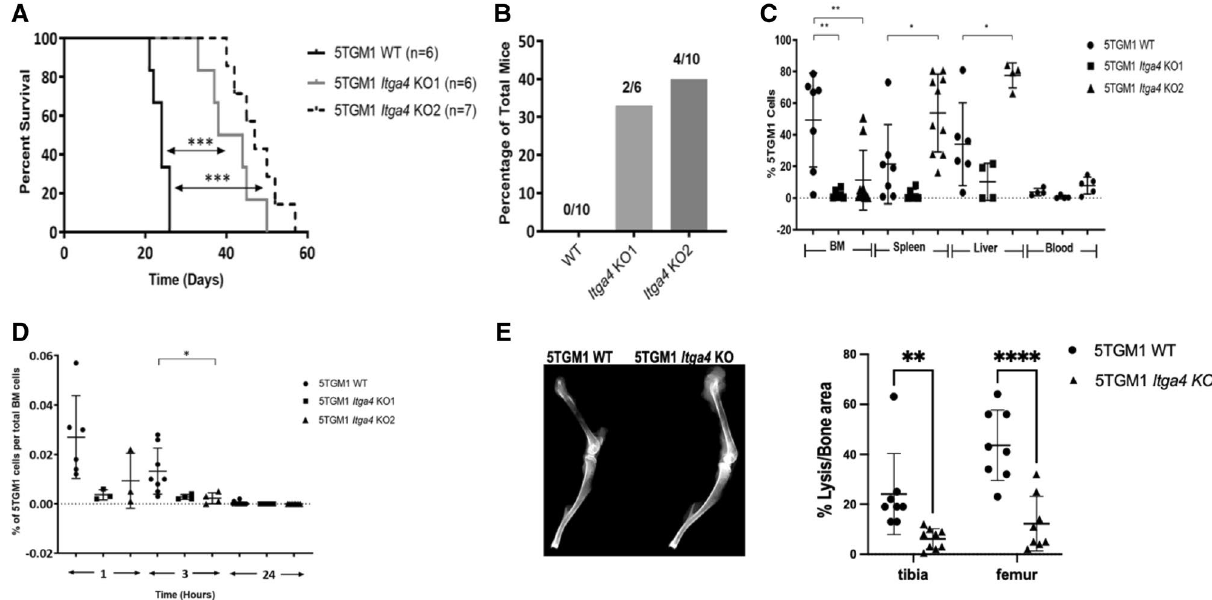
Figure 3. The in vivo characteristics of the Itga4 KO 5TGM1-GFP cells were compared with the WT 5TGM1- GFP cells in the intravenous (i.v.) KaLwRij mouse model. ( A ) The Itga4 KO 5TGM1-GFP cells engrafted in immunocompetent C57BL/KaLwRij mouse model demonstrated significant survival advantage. ( B ) Quantitation of number of mice that developed extramedullary tumors detected in mice engrafted with WT or Itga4 KO 5TGM1-GFP cells. ( C ) Flow cytometry was used to measure percent 5TGM1 cell levels in different tissues. Each symbol represents a unique mouse. ( D ) Lack of Itga4 in 5TGM1 cells led to reduced BM homing in in vivo competitive homing experiment (n = 18). Shown is the percentage of 5TGM1 cells in the BM. All graphs represent data at time of death. ( E ) Assessment of myeloma bone disease three weeks from inoculation of 5TGM1 WT vs Itga4 KO, representative X-ray (left) and quantification of hypointense areas/total bone area in tibia and femur (N = 5